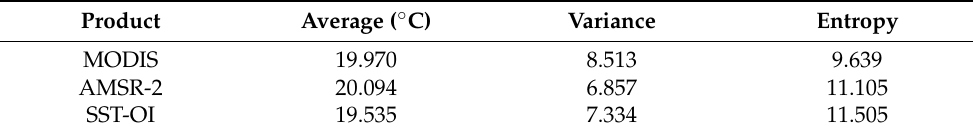
Table 1. Comparison of MODIS, AMSR-2. and OI Fusion SST Data Quality Parameters.